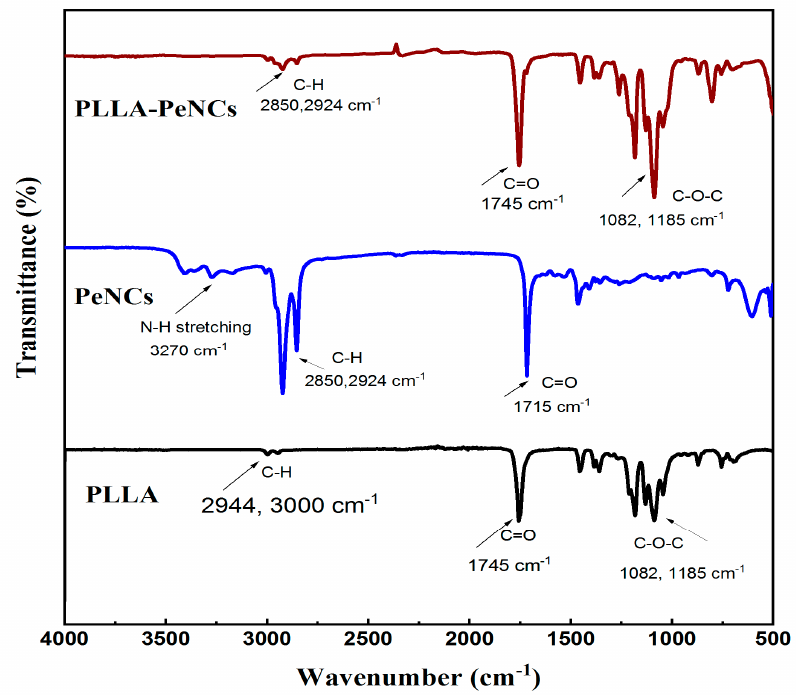
Figure 5. FTIR spectra of PLLA nanofibers, pure FAPbBr 3 NCs, and perovskite nanocrystals encap- sulated by PLLA